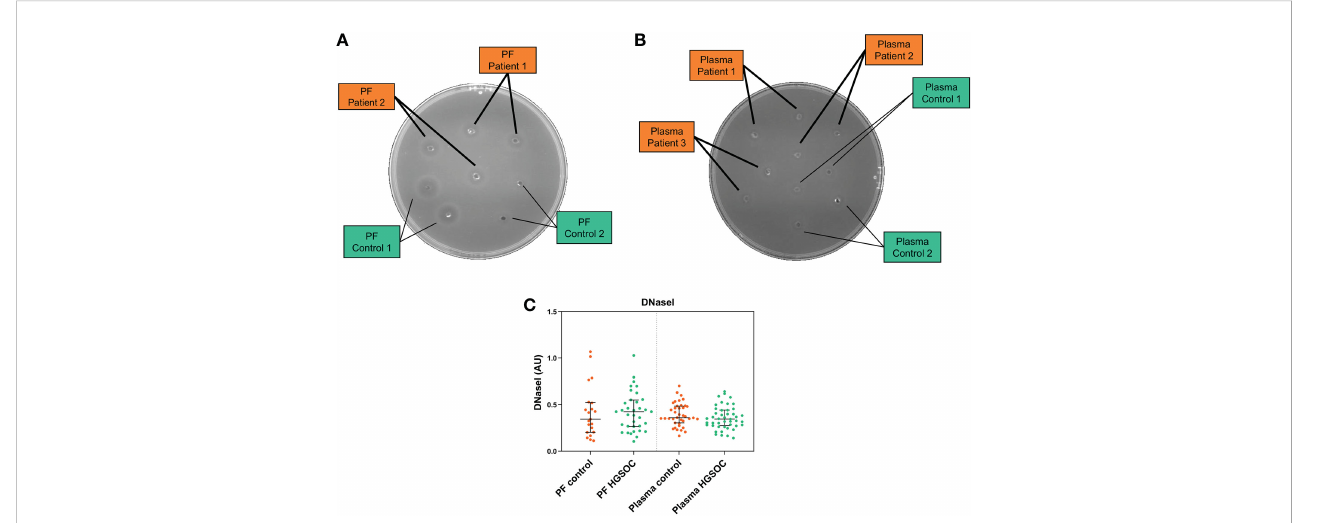
FIGURE 3 Degradation halo by DNaseI enzyme activity of (A) peritoneal fl uid (PF) and (B) plasma samples of patients with high-grade serous ovarian cancer (HGSOC) (n=35 and n=45, respectively) and control women (n=21 and n=40, respectively) (Single radial enzyme-diffusion assay). (C) Qualitative comparison of DNaseI enzyme activity in PF and plasma between clinical groups. AU, arbitrary units. Mann Whitney U